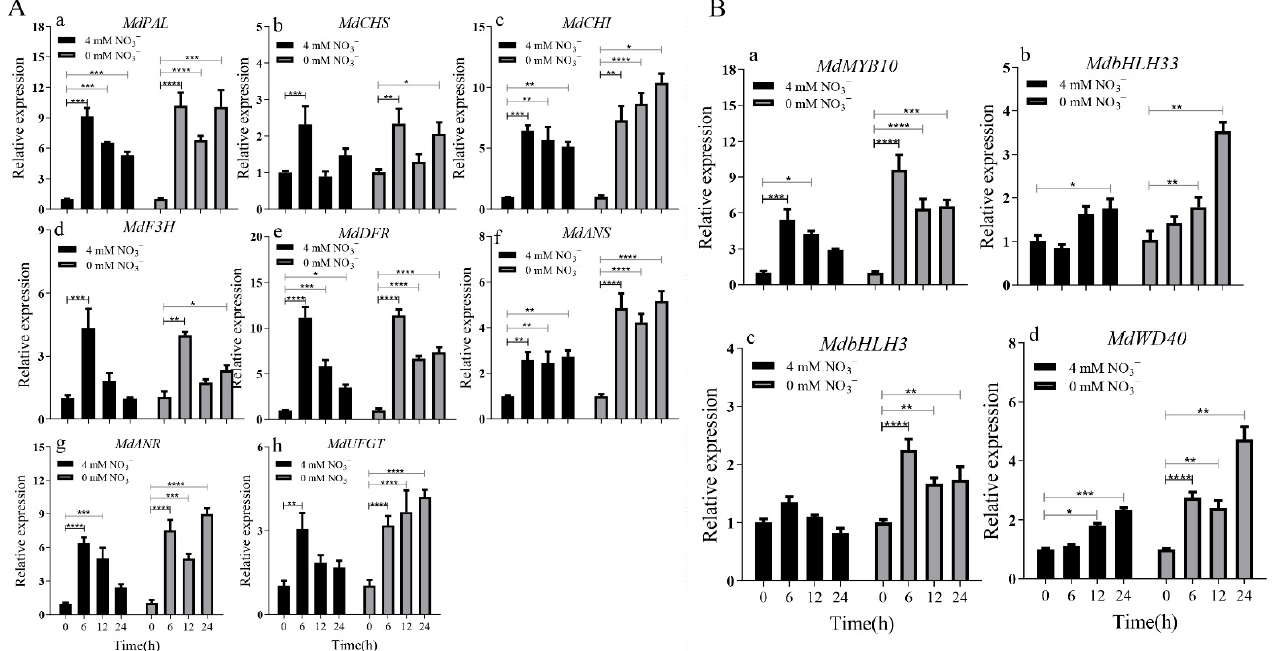
Figure 4. Relative expression of anthocyanin synthesis-related genes in ‘Daihong’ tissue culture seedlings grown in mediums with 4 and 0 mM NO 3 − . ( A ) Relative expression of structural genes involved in anthocyanin synthesis ( a : MdPAL, b : MdCHS, c : MdCHI, d : MdF3H, e : MdDFR, f : MdANS, g : MdANR, h : MdUFGT ). ( B ) Relative expression of regulatory genes related to anthocyanin synthesis ( a : MdMYB10 , b : MdbHLH33 , c : MdbHLH3 , d : MdWD40 ). The relative level of anthocyanin synthesis-related genes in ‘Dahong’ tissue culture seedlings at 0 h was set to 1. The bars represent means ± SD ( n = 3). Asterisks indicate statistically significant differences (* p < 0.05; ** p < 0.01; *** p < 0.001; **** p < 0.0001).